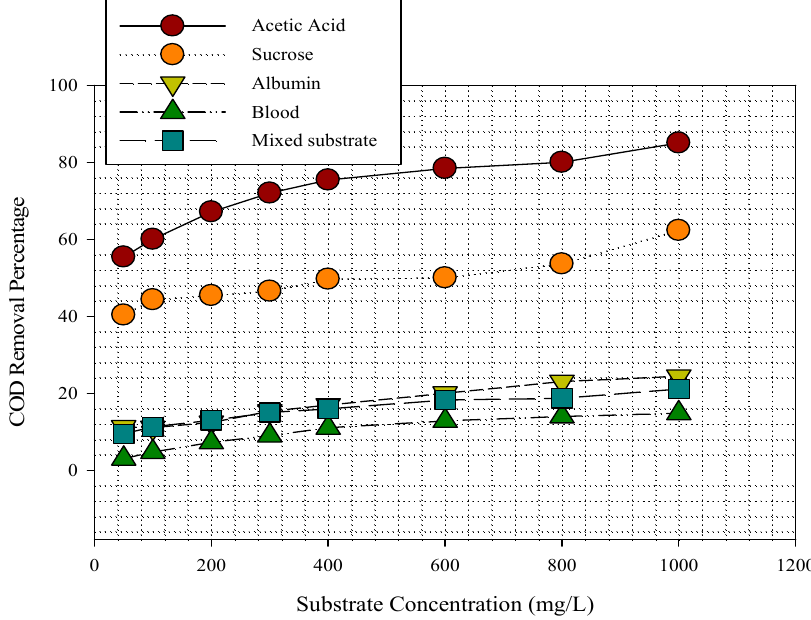
Figure 2. Substrate removal (COD) percentage at various substrates concentrations in MFC.